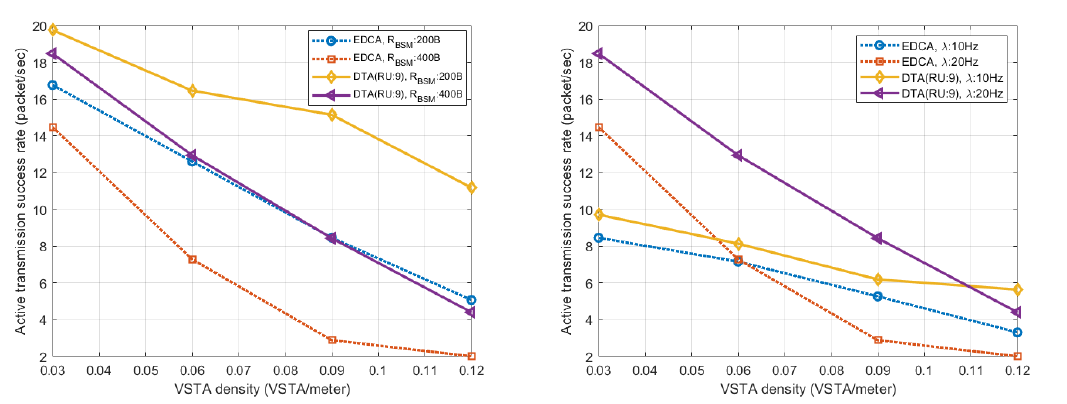
Figure 12. Performance impact of the payload size and the arrival